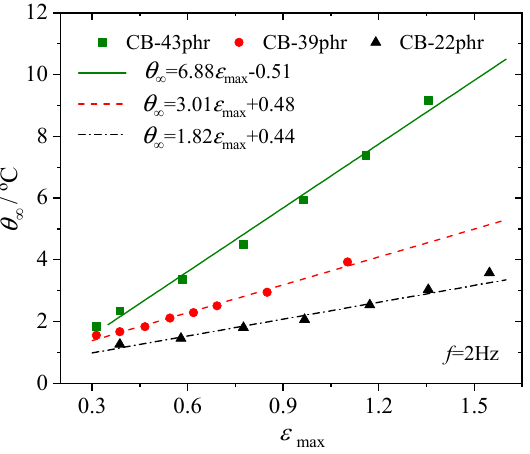
Figure 9. θ ∞ vs. <!-- MathType@Translator@5@5@MathML2 (no namespace).tdl@MathML 2.0 (no Figure 9. θ ∞ vs. ε max data for cyclic loaded filled rubber with various carbon black contents